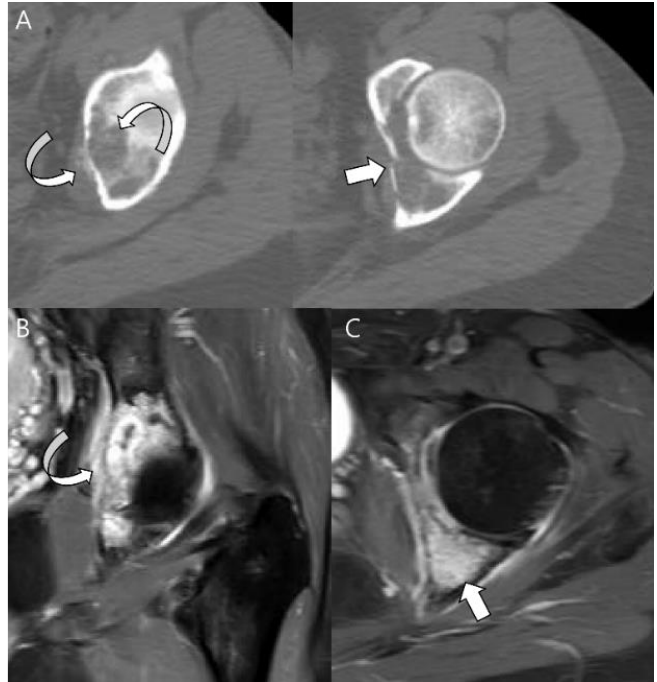
Figure 7. High-grade conventional chondrosarcoma of the acetabulum in a 49-year-old woman. ( A ) Axial CT scans reveal cortical breakage (thin arrow) with extraosseous extension containing matrix mineralization (curved arrow) in the left acetabulum. ( B ) Axial and ( C ) axial T1-weighted enhanced images with fat suppression show diffusely enhancing intraosseous (arrow) and extraosseous tumor components (curved arrow).